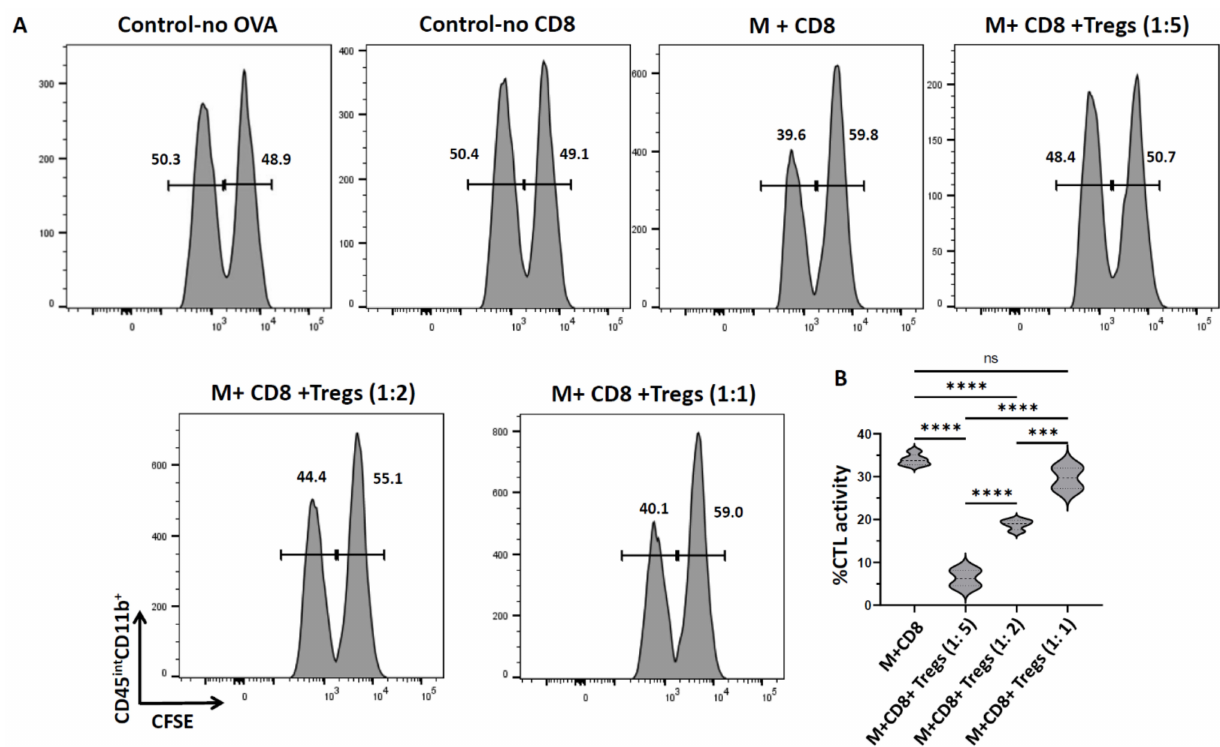
Figure 1. Tregs suppress cytotoxic T-lymphocyte activity against primary microglia . CD8 + T − cells were isolated from the spleens of rAd5 − OVA − primed OT − 1 mice using a negative selection kit. CD8 + T − cells were then co − cultured with microglial cells (10:1) loaded with ovalbumin − specific SIINFEKL peptide and labeled with CFSE (M). Microglia were pre − incubated with Tregs for 1 h in different ratios to CD8 + (CD8 + :Tregs: 1:5, 1:2, and 1:1). In vitro cytotoxicity was determined after 18hr. ( A ) Representative histograms show CFSE-labeled microglia harvested from the plate after 18 hr of co-culture with OT − 1 CD8 + T-cells ± Tregs. Control is CFSE staining of microglia either without a specific peptide or without CD8 + T − cells. ( B ) Graphical representation of % CTL activity [1 − (control group hi/lo ratio: experimental group hi/lo ratio)] × 100. *** p < 0.001, **** p < 0.0001. Data shown are representative of three separate experiments using 3 wells/group/experiment and expressed as mean ± SE. rAd-OVA-primed OT-1 mice ( n = 2/experiment) and IL − 2/anti − IL − 2 − injected C57BL/6 mice ( n =